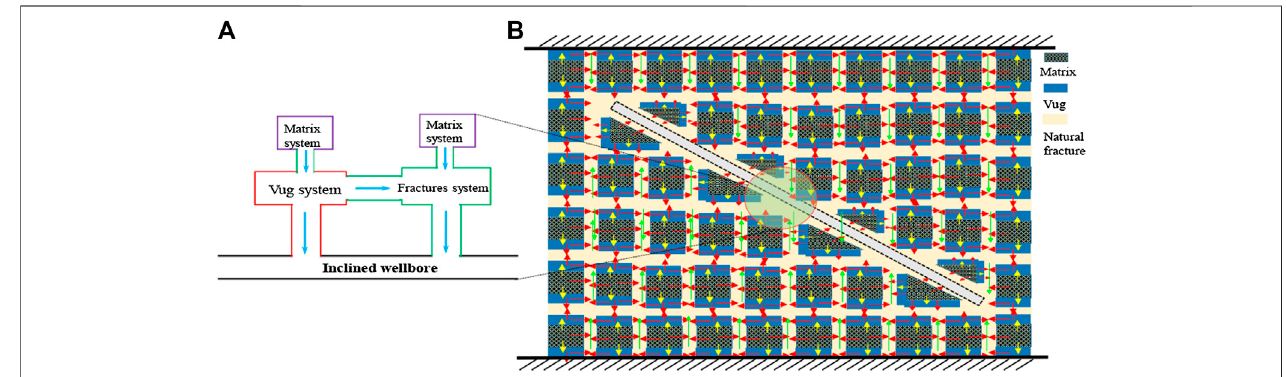
FIGURE 3 | Flow scheme of FVCHRs with triple-porosity dual-permeability behavior.